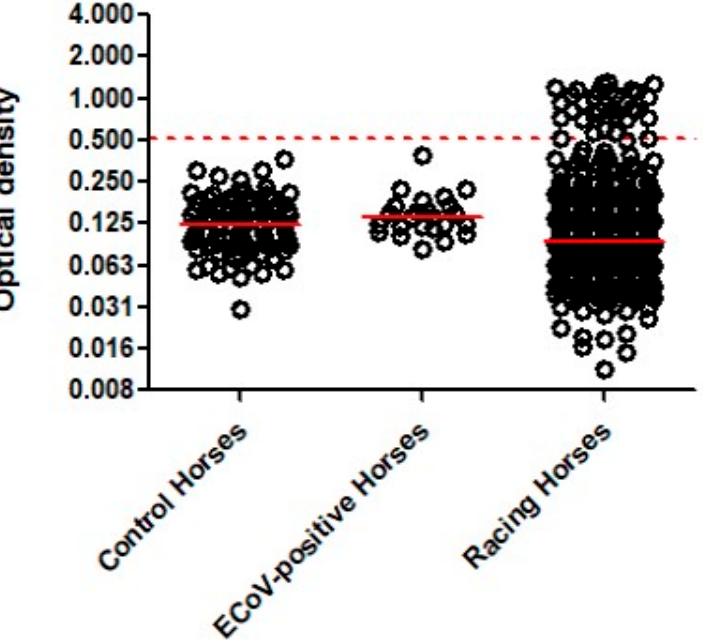
Figure 1. ELISA results from 88 pre-COVID-19 control horses, 24 ECoV-seropositive horses and 633 serum samples collected from 587 racing Thoroughbreds against the recombinant receptor-binding domain of SARS-CoV-2 spike protein. The dashed red line represents the cut-off (0.507). The solid red lines represent the median OD.